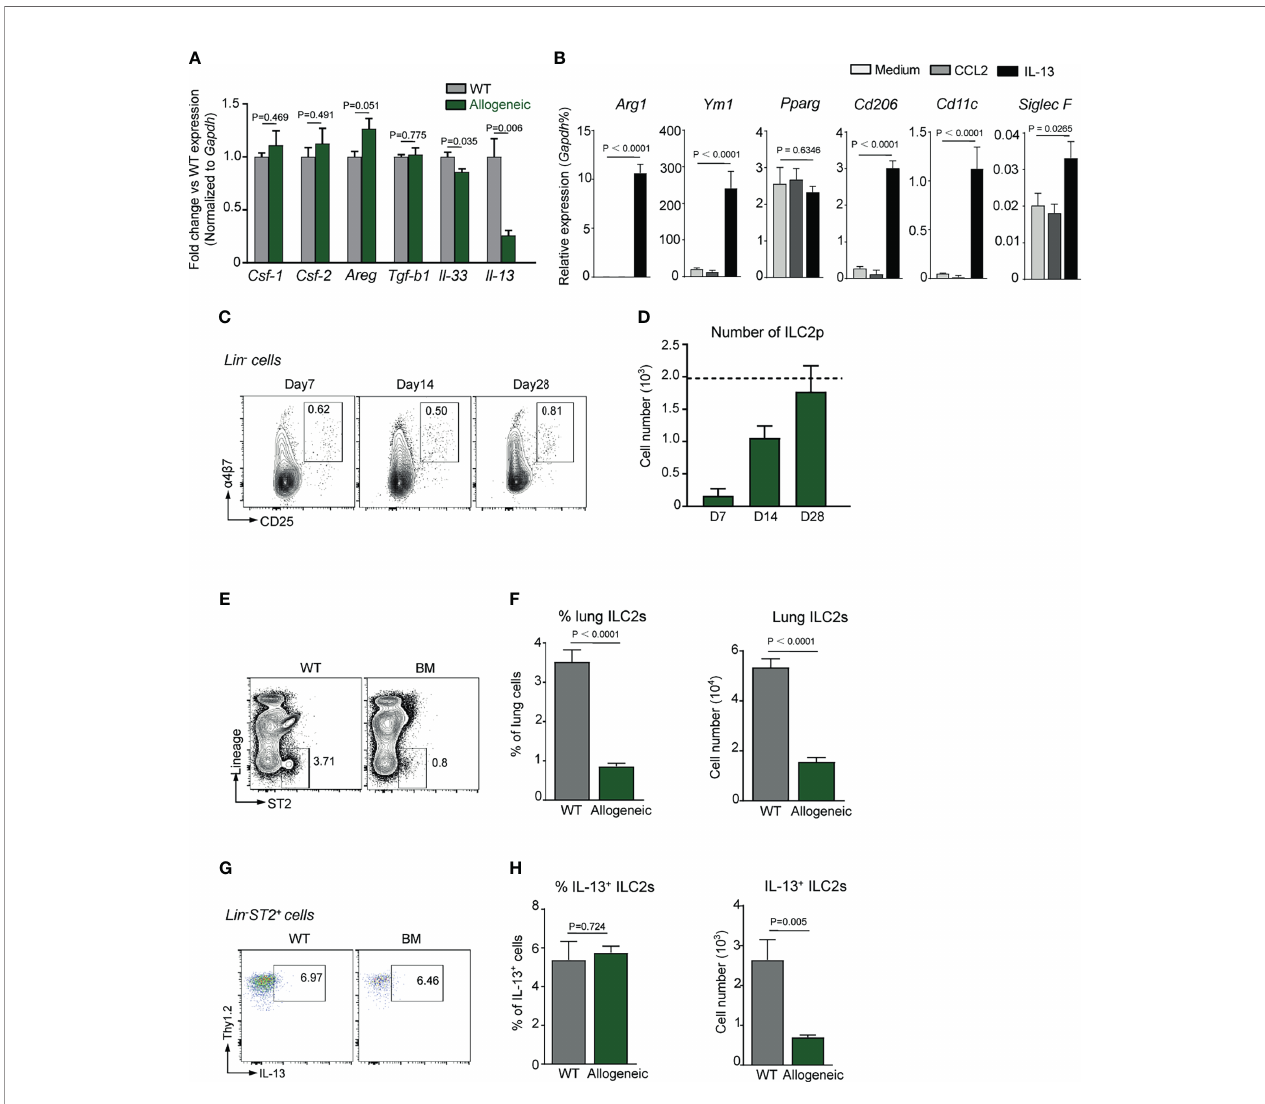
FIGURE 2 | Defective ILC2s and IL-13 expression in allogeneic recipient mice after TCD-BMT. (A) Gene expression was analyzed in lungs of 28-day allogeneic recipient mice. Gene expression was normalized by relative fold change of each gene versus that in WT mice. A representative result of two independent experiments with four to fi ve mice in each group is shown. (B) Monocytes were isolated from WT C57BL/6 bone marrow and cultured in the presence of 50 ng/ml of recombinant IL-13 or CCL2. Twenty-four hours later, gene expression was normalized to relative expression vs. Gapdh . A comprehensive analysis of three independent experiments is shown. Data are represented as mean ± SEM. (C, D) ILC2 precursors (Lin − a 4 b 7 + CD25 + ) were analyzed in bone marrow of allogeneic recipient mice after BMT. Dotted line indicates the level of ILC2p cells in WT mice. (E) Representative plots of lung ILC2 (Lin − ST2 + ) cells in lung of 28-day allogeneic recipient mice are shown. (F) Frequency and absolute number of lung ILC2s are shown. Data shown are the pooled results of two independent experiments with three to fi ve mice per group in each experiment. Data are represented as mean ± SEM. (G, H) IL-13 production by lung ILC2s in mice were assessed by intracellular staining. Frequency and absolute number of lung IL-13 + ILC2s are shown. Data are represented as mean ± SEM (n = 5). ILC2, group 2 innate lymphoid cell; TCD, T cell-depleted; BMT, bone marrow transplantation; WT, wild